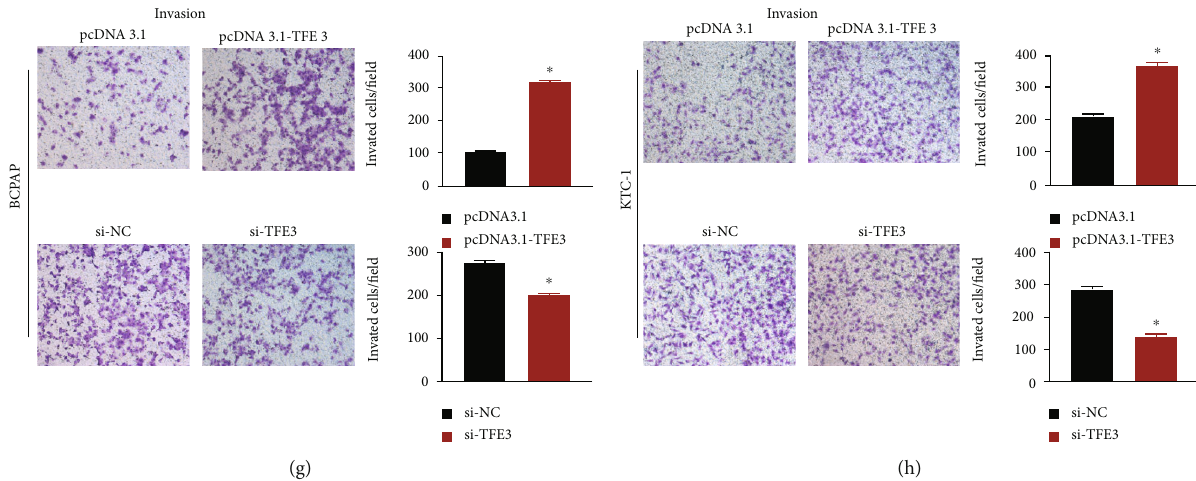
Figure 4: TFE3 accelerates PTC cell migration and invasion in vitro. (a, b) Wound healing assays showed that overexpression of TFE3 increased thyroid cancer cell migration. (c, d) Silencing of TFE3 reduced PTC cell migration. (e – h) Transwell assays indicated that overexpression of TFE3 increased the migratory and invasive ability of PTC cells, while knockdown of TFE3 decreased the migratory and invasive ability of PTC cells ( ∗ P < 0 : 05